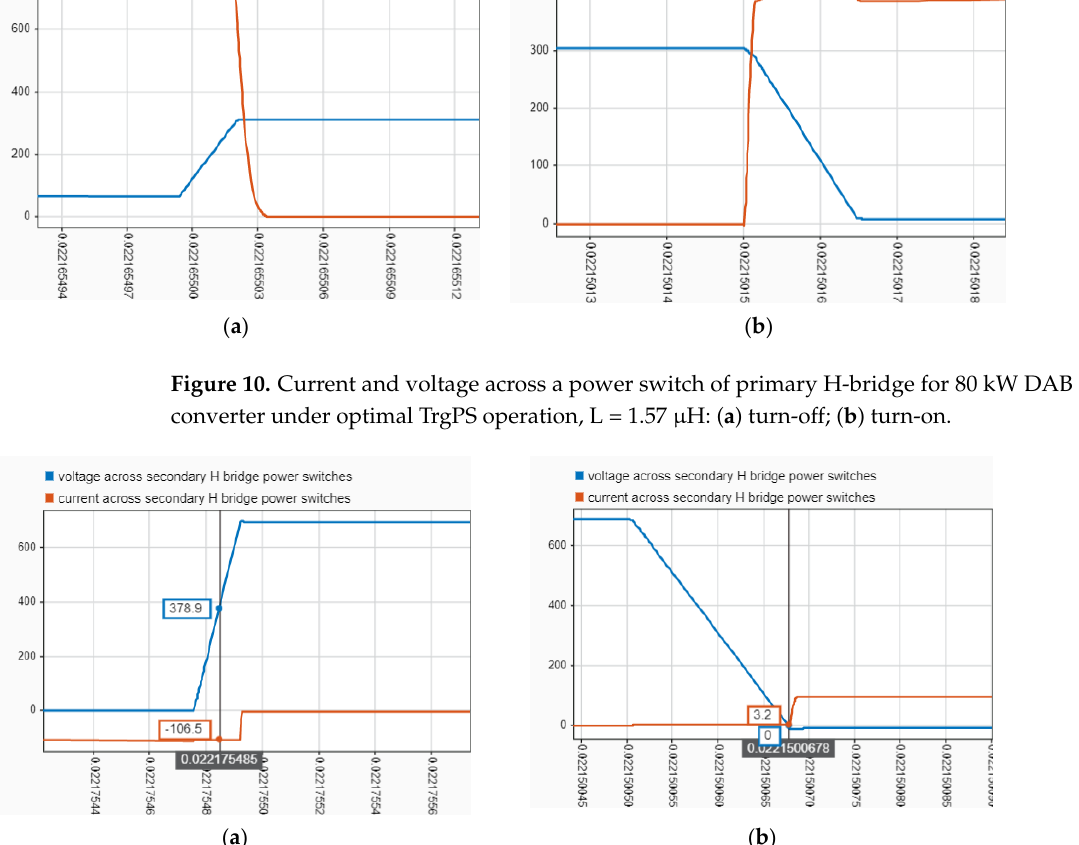
Figure 11. Current and voltage across a power switch of secondary H-bridge for 80 kW DAB DC-DC converter under optimal TrgPS operation, L = 1.57 µH: ( a ) turn-off; ( b ) turn-on.